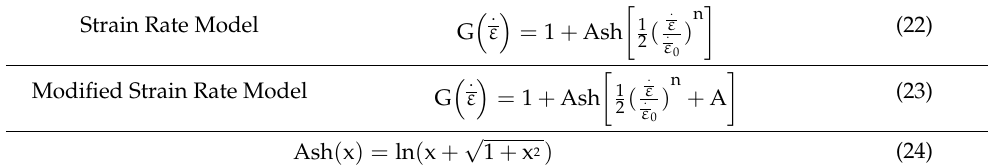
Table 7. Equations of strain rate models.